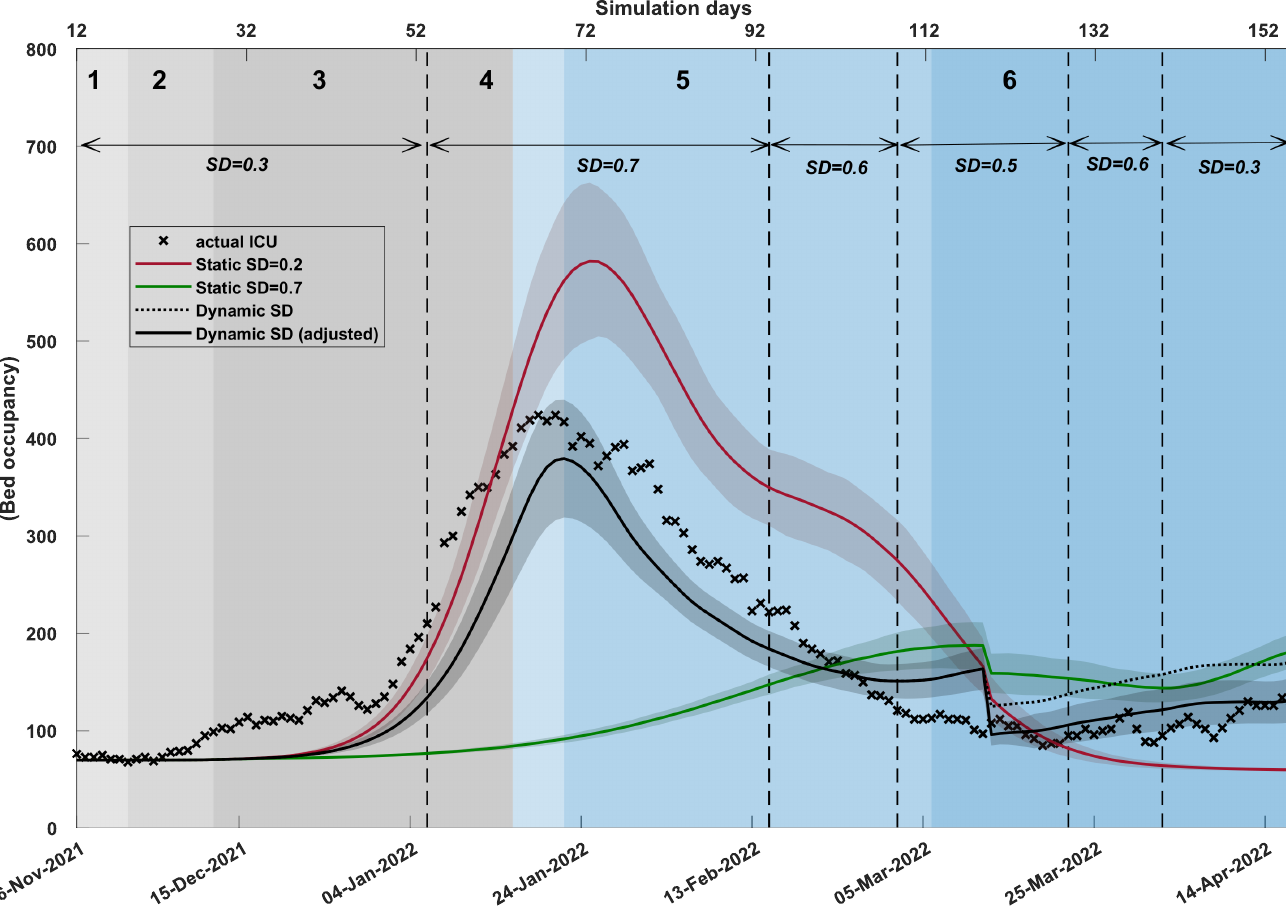
Fig 3 and Table N in S1 Text show that the hospitalisation curve (occupancy) generated by